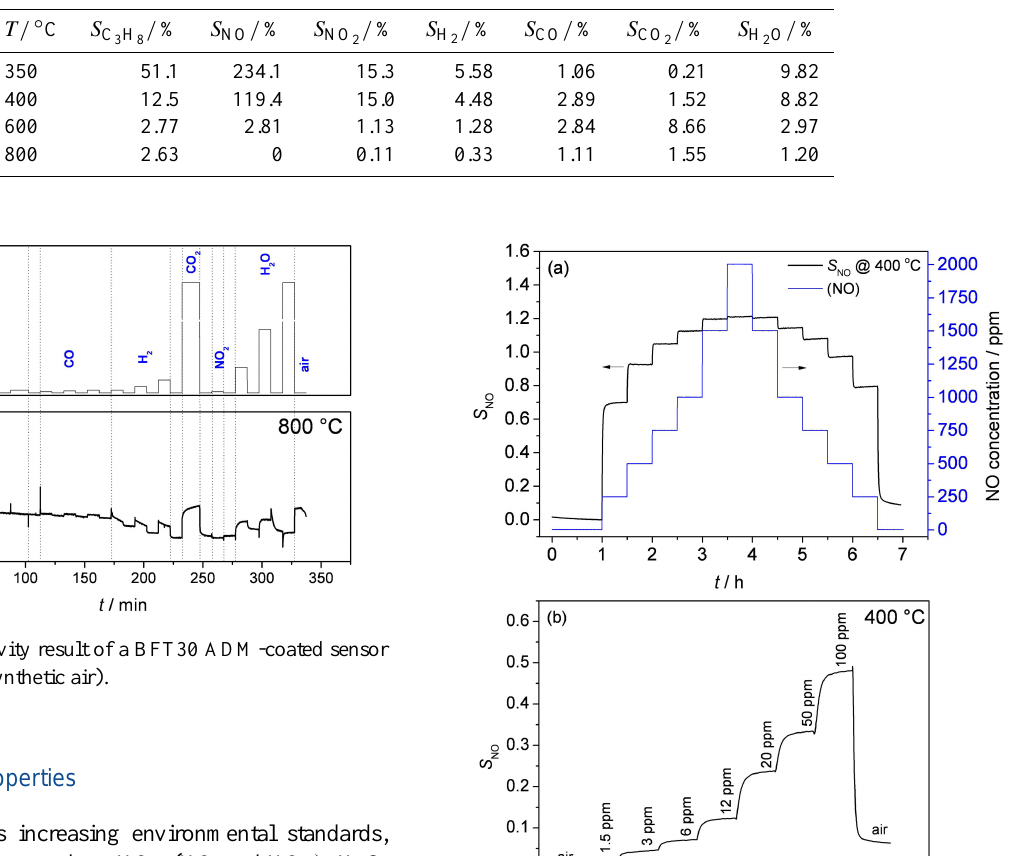
Table 1. Response, S component , as defined in Eq. (4) of the BFT30 ADM thick film sensor to other exhaust components.